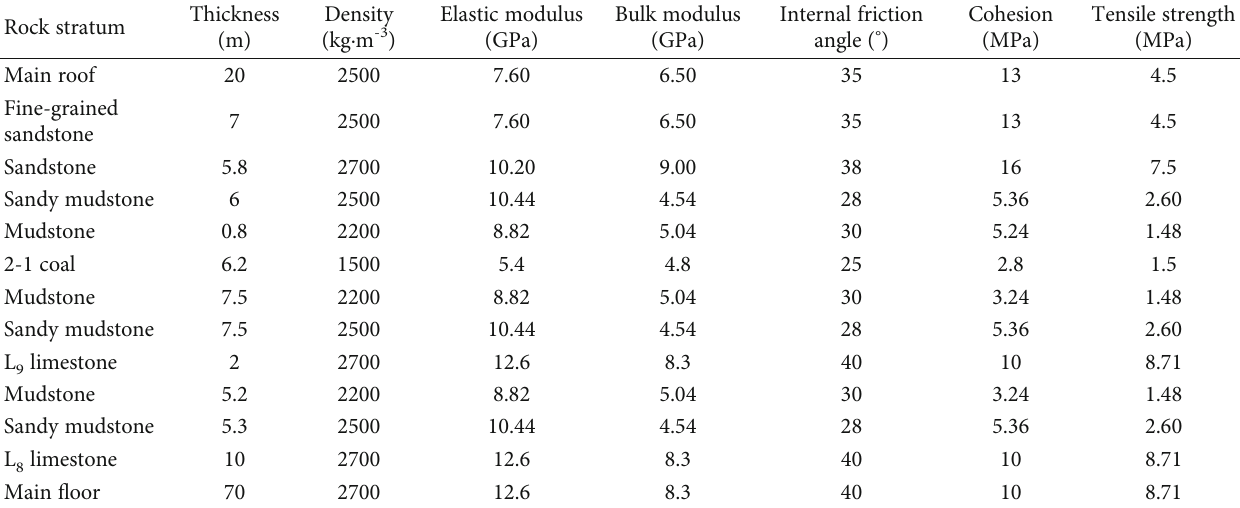
Figure 3: The simulation model of the fl oor extraction roadway at di ff erent locations. Table 1: Rock mechanic parameters used in the model.